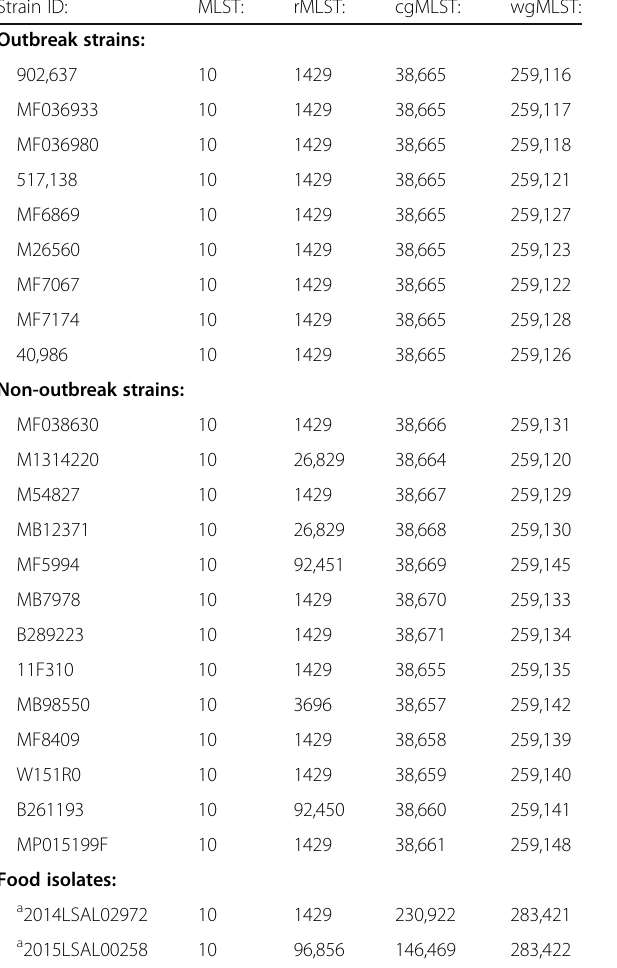
Table 1 MLST, rMLST, cgMLST and wgMLST results of Salmonella